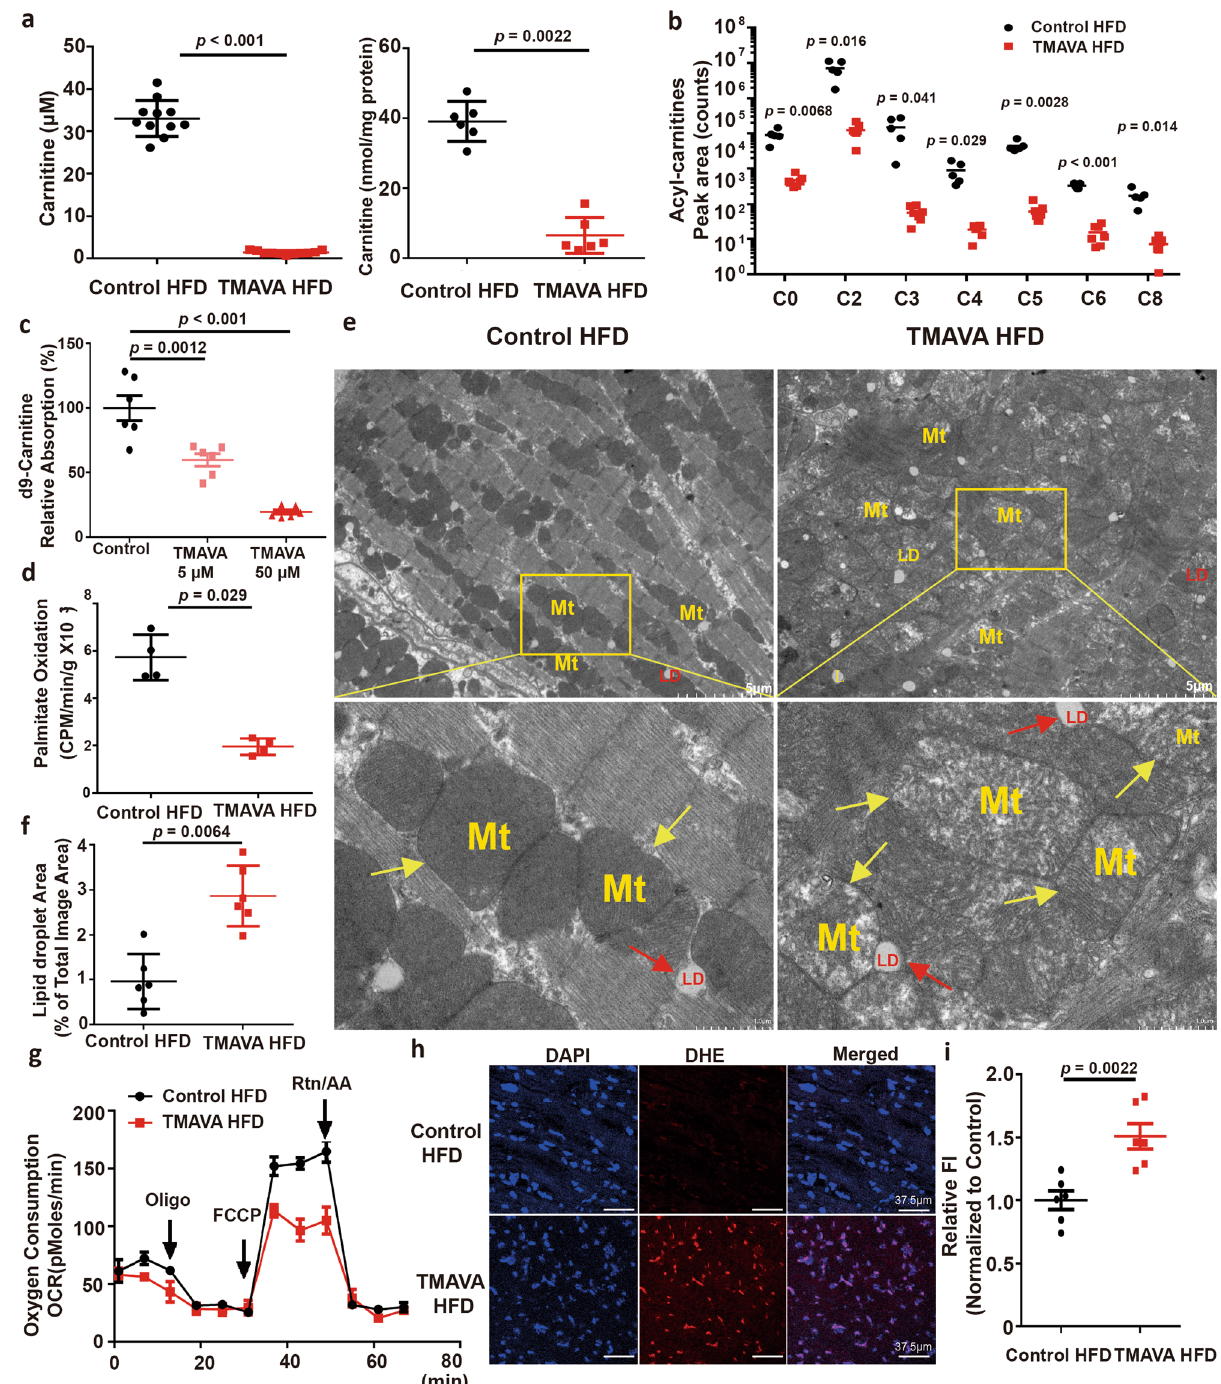
Fig. 4 Fatty acid oxidation (FAO) was inhibited and myocardial mitochondria were dysfunctional upon TMAVA treatment. Mice were fed an HFD for 12 weeks, with the TMAVA group treated with 0.325% TMAVA (m/v%) in the drinking water in [( a , b ) and ( d ) – ( i )]. a TMAVA treatment decreased the carnitine content in plasma (left) ( n = 11) and heart (right) ( n = 6). b Acyl-carnitine levels were decreased in the heart. Cardiac individual acyl-carnitine species were measured by LC – MS ( n = 5). c d9-carnitine uptake in primary neonatal rat ventricular myocytes (NRVM) was measured in the presence of 5 and 50 μ M TMAVA ( n = 6/concentration). d Cardiac fatty acid β -oxidation activity was measured ex vivo in control and TMAVA-treated mice using 3 H-palmitic acid ( n = 4). e Electron microscopy of hearts from control and TMAVA-treated mice fed an HFD for 12 weeks. LD lipid droplets, Mt mitochondria ( n = 6). f Lipid droplet percentage (% of the total image area) was calculated with ImagJ ( n = 6). g Respiratory rates of heart mitochondria isolated from WT mice and TMAVA-treated mice after 12 weeks on HFD. OCR was measured with palmitic acid as the substrate using Seahorse metabolic analyzer ( n = 3). h Myocardial tissue ROS levels were detected using the oxidant sensitive probe dihydroethidium (DHE) (red). Nuclei were counterstained with DAPI (blue). i Quanti fi cation of the fl uorescence intensity of DHE staining (Red) ( n = 6/group). Statistical signi fi cance was evaluated by two-tailed unpaired Student ’ s t test [( b , f , i )], one-way ANOVA [( c )], or two-tailed nonparametric Mann – Whitney test [( a , d )]. (* P < 0.05, ** P < 0.01, *** P < 0.001). Data are expressed as mean ± SEM. Source data are provided as a Source Data fi le. NATURE COMMUNICATIONS| (2022) 13:1757 |https://doi.org/10.1038/s41467-022-29060-7|www.nature.com/naturecommunications